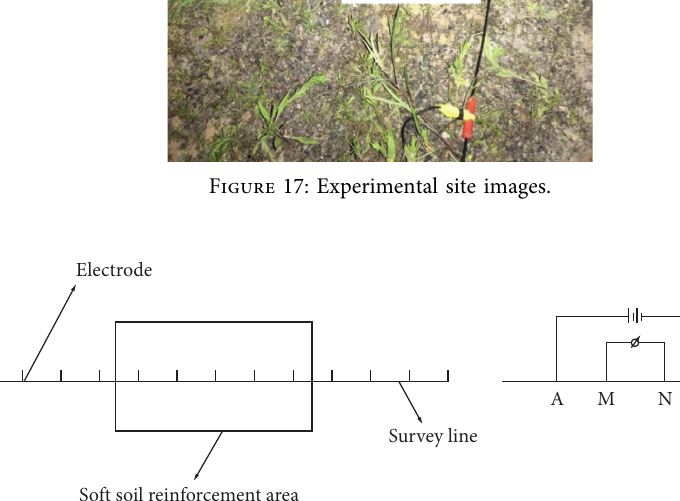
Figure 18: Schematic diagram of the experimental